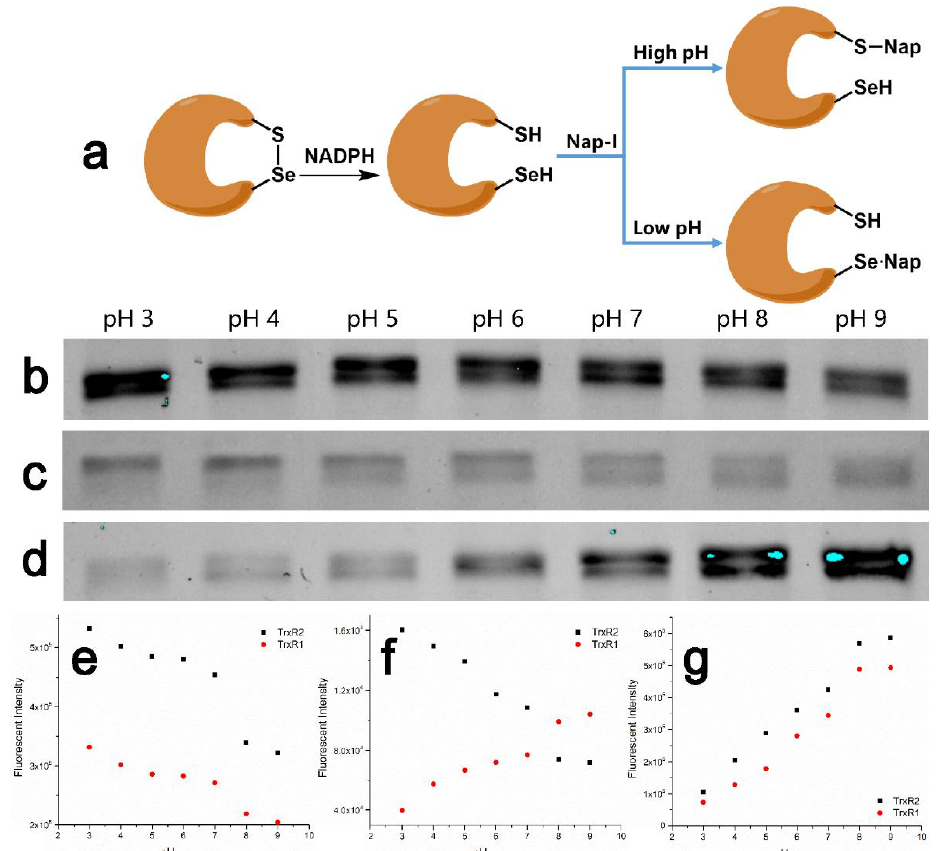
Figure 5. ( a ) Mechanism of the labeling of TXNRD by Nap-I at different pH; ( b ) SDS-PAGE fluorescence image of Nap-I-labeled TXNRD from mouse liver reduced by NADPH at pH 6.5 with different labeling pH; ( c ) SDS-PAGE fluorescence image of Nap-I-labeled TXNRD from mouse liver reduced by NADPH at pH 7.4 with different labeling pH; ( d ) SDS-PAGE fluorescence image of Nap-I-labeled TXNRD from mouse liver reduced by NADPH at pH 8.5 with different labeling pH; ( e ) comparison of Nap-I-labeled TXNRDs from mouse liver reduced by NADPH at pH 6.5 at different pH; ( f ) comparison of Nap-I-labeled TXNRDs from mouse liver reduced by NADPH at pH 7.4 at different pH; ( g ) comparison of Nap-I-labeled TXNRDs from mouse liver reduced by NADPH at pH 8.5 at different pH. Quantity of protein per band: ca. 1 µ